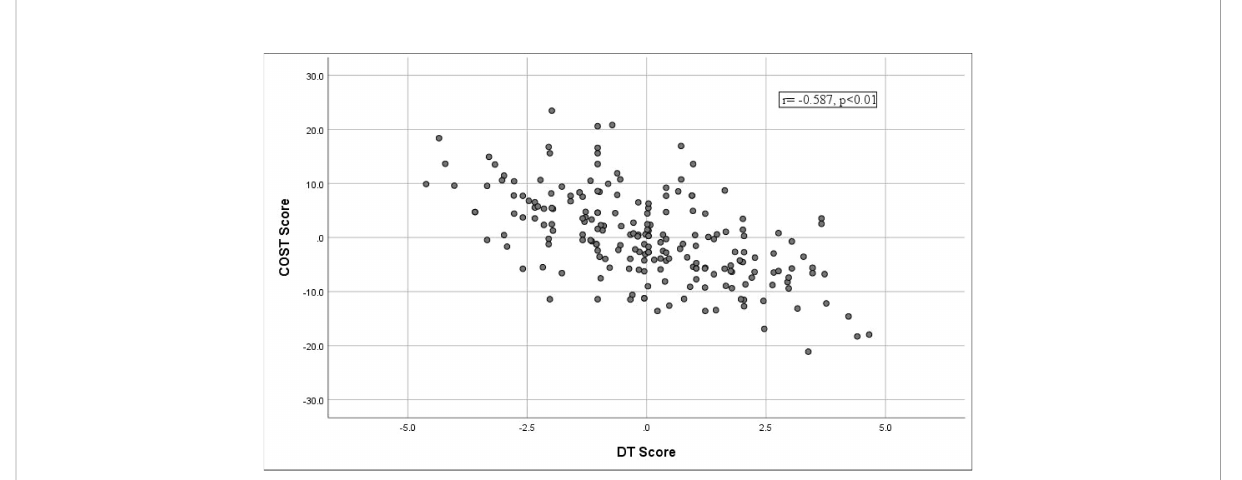
FIGURE 2 Correlation between fi nancial toxicity and psychological